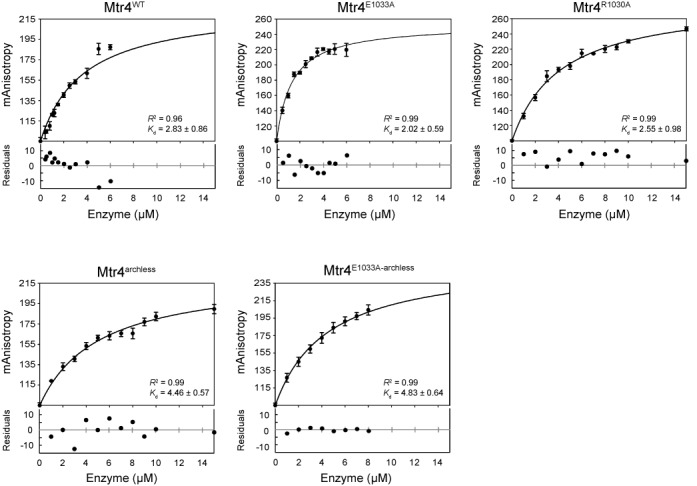
The ratchet helix and the arch mutations have minimal effect on RNA-binding interactions. Fluorescence anisotropy monitored using a fluorescein-labeled poly(A) RNA substrate, plotted as a function of Mtr4 concentration. The correlation coefficient (R2) and calculated Kd values (μM) for each curve are inset. Data presented here represent averages from three independent experiments; error bars represent SD. Residual value plots for the curve fits of wild-type and all Mtr4 mutations are shown below their respective curves. All plots passed a residual runs test.